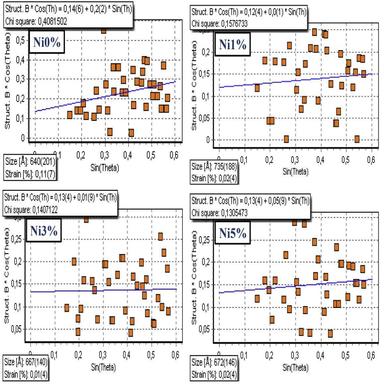
Williamson-Hall plots for all samples synthesized with different nickel ratios.